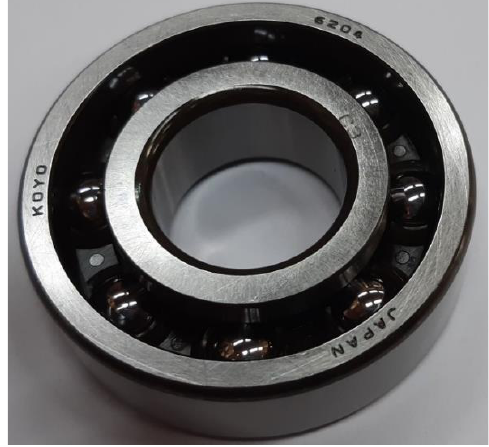
Figure 3. A pristine bearing.